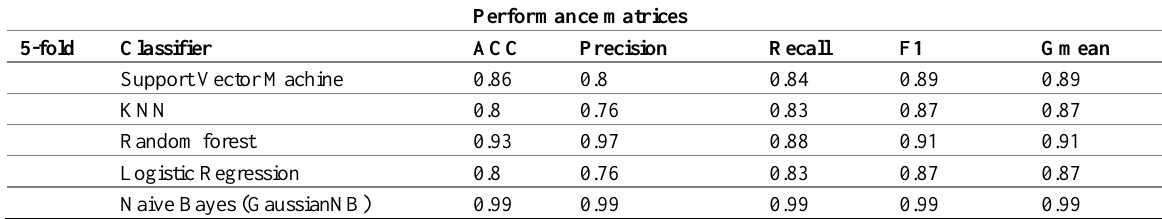
Table 6 : Comparison of machine learning models